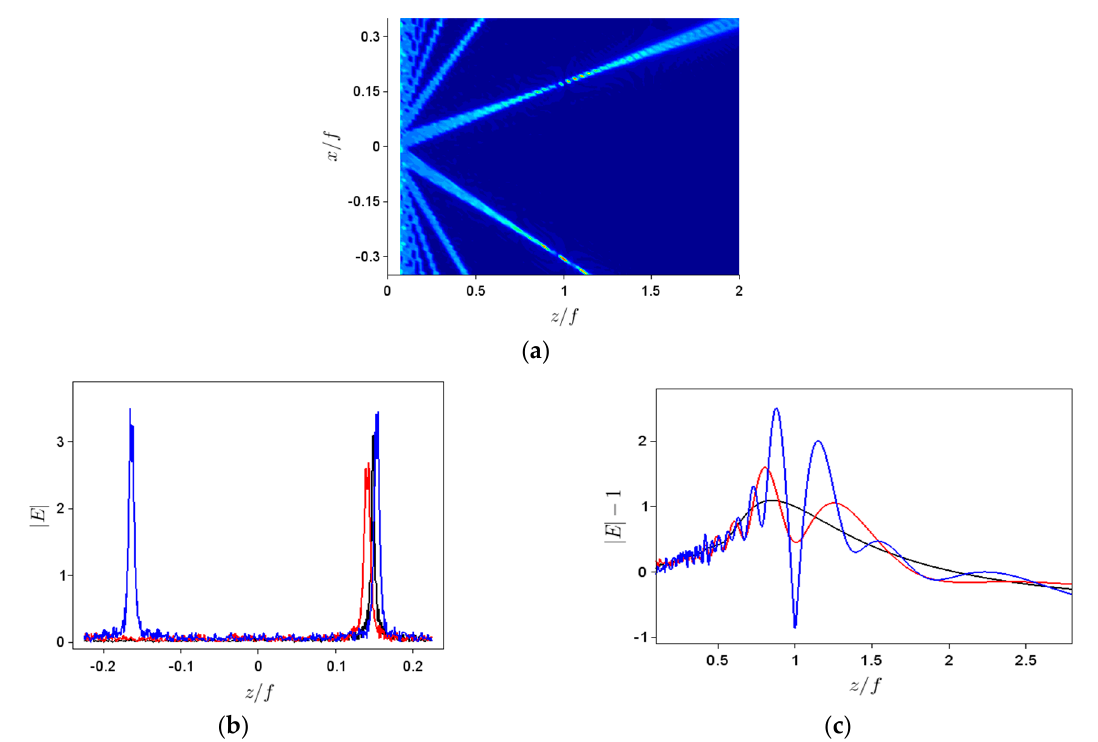
Figure 9. ( a ) Spatial distribution of the field modulus for θ = 10°, N /2 = 600 and ∆ φ m = 30°. Corresponding ( b ) transversal and ( c ) longitudinal field distributions for N /2 = 400 (black line), 600 (red line) and 800 (blue line).